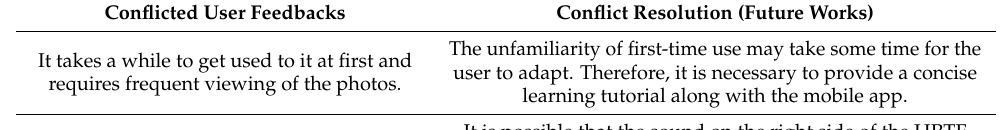
Table 13. Critical user feedback and future